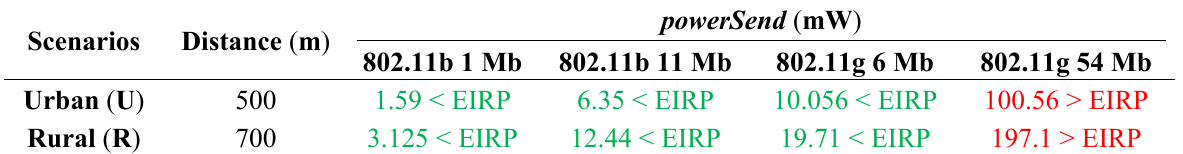
Table 10. Summary of minimum transmission powers required for our target